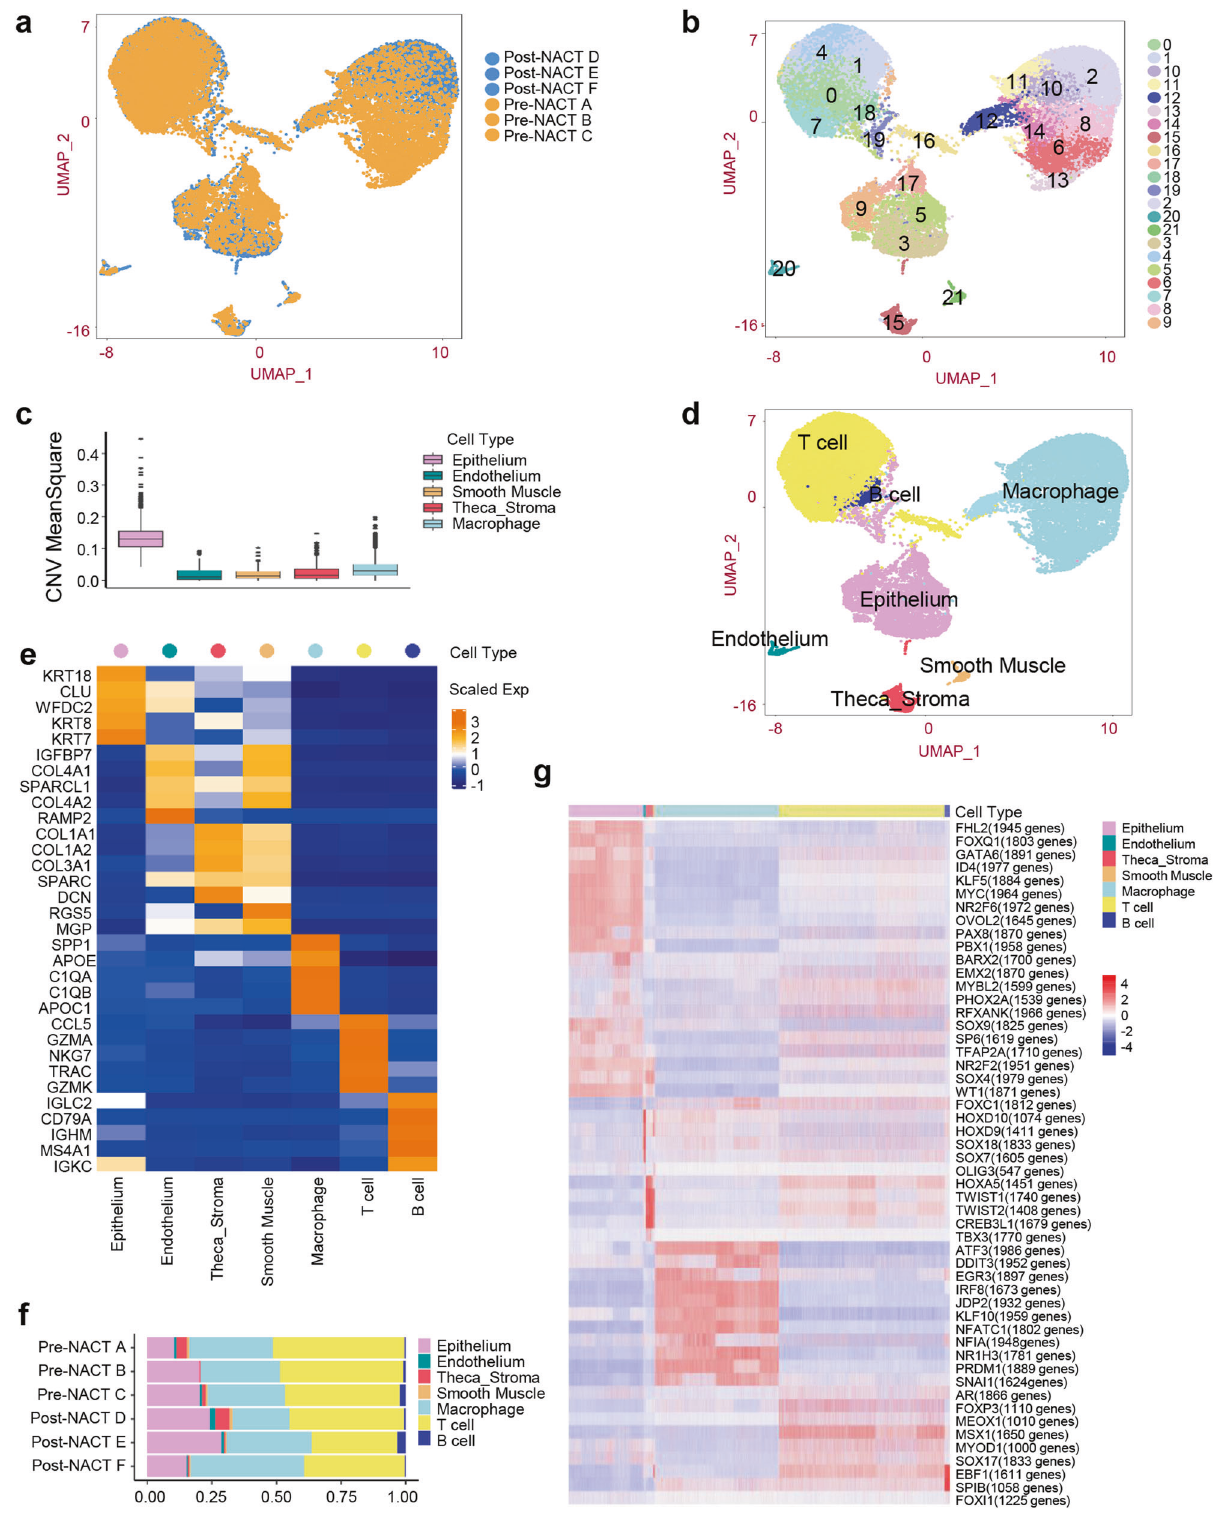
Fig. 2 scRNA-seq pro fi ling of the pre-NACT and post-NACT high-grade serous fallopian tube carcinoma samples. a UMAP plots showing cell groups by color in the pre-NACT and post-NACT sample groups. b UMAP plots showing pre-NACT and post-NACT cells, clustered and color-coded according to the group. c Box plots showing the CNV signals for each cell type. d UMAP plots showing the cell types by color. e Heatmap showing the top marker genes in each cell type. f Histogram indicating the proportion of cell types in each analyzed sample. g Heatmap showing the expression regulation by transcription factors in each cell type, as estimated using SCENIC. UMAP uniform manifold approximation and